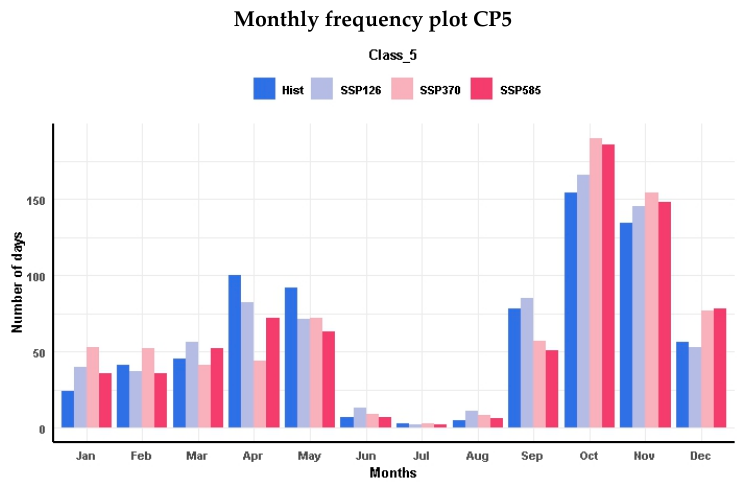
Figure 7. As in Figure 3 for CP5. Most parts of Iran are affected by the dynamic high pressure of Siberia in CP5, which enters the country from the northeast. The low pressure is located in the east of Europe and the north of the Black Sea, and another low is over the Red Sea. In the mid-level, there is a trough in the southeast of Europe, and the ridge is located east of the Caspian Sea. Dynamic high-pressure strengthening and formation of isobar 1024 are predicted for the future. Moreover, future patterns predict an increase in geopotential height in the Arabian Sea. The highest number of occurrences of CP5 is in October and November, followed by April, May, and September. The frequency of events in the future projection decreases